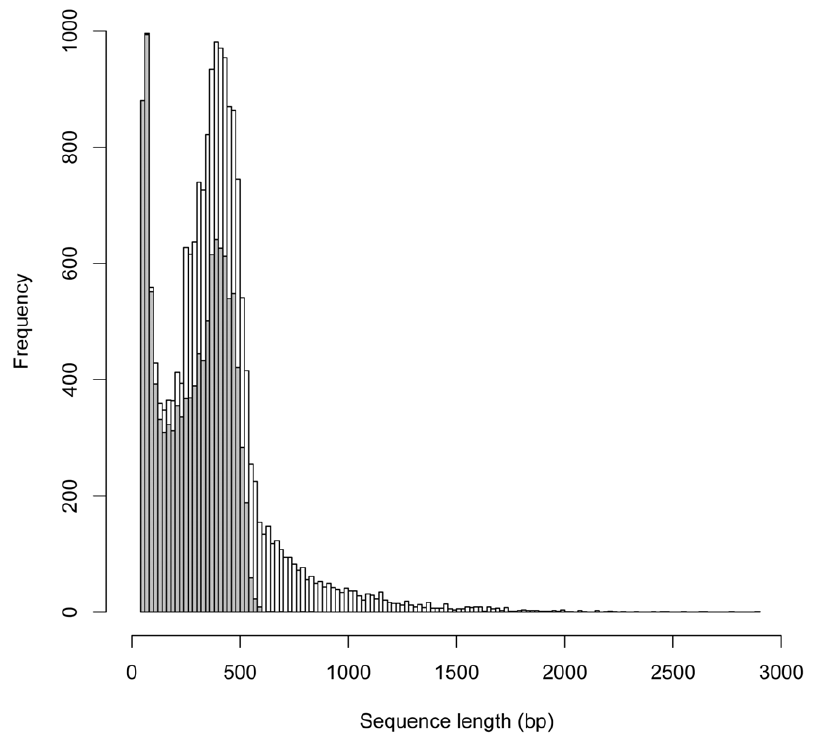
Figure 1. Length distribution of Aphisglycines B1 transcripts from 454 sequencing. The length distribution of soybean aphid Aphis glycines transcript sequences. The grey bars represent the singleton sequences and the white bars represent contig sequences.